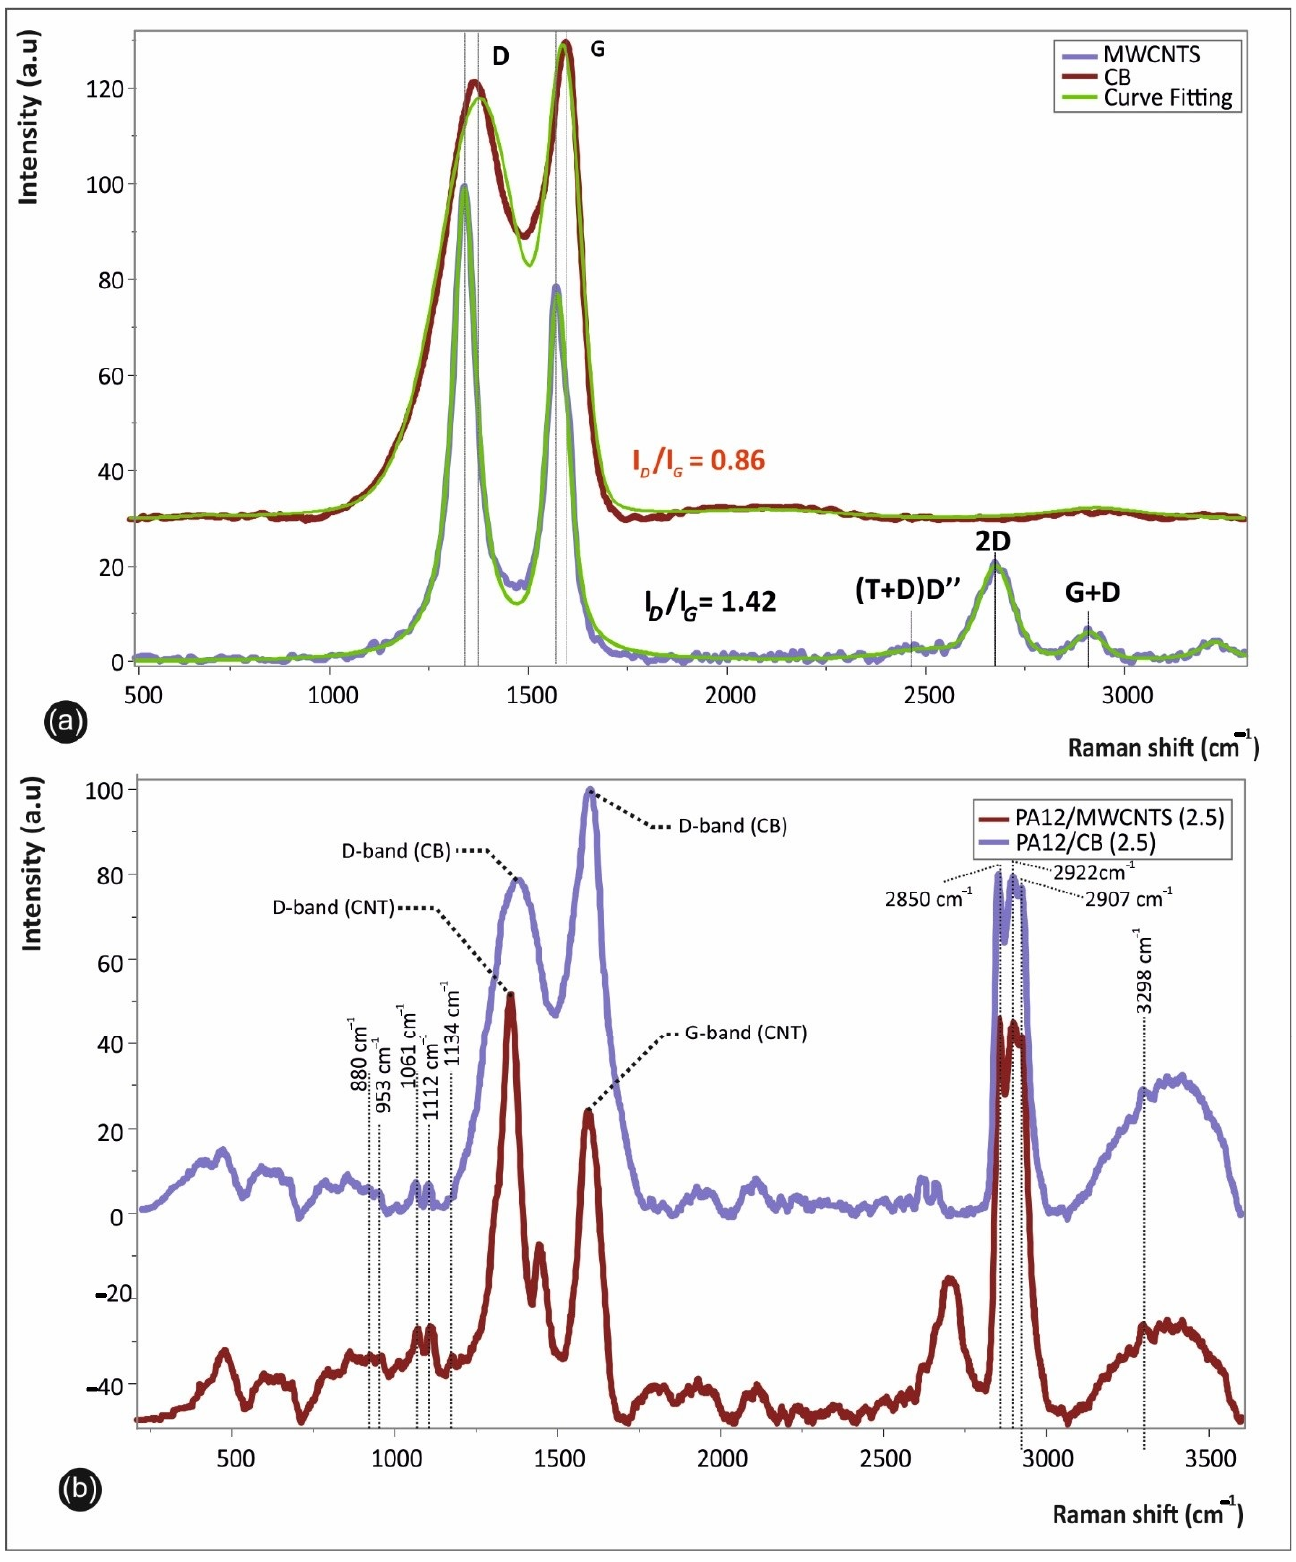
Figure 4. Raman spectra of ( a ) MWCNTs and highly graphitized CB carbon nanoallotrope fillers, together with the corresponding fitting lines; and ( b ) PA12/MWCNT and PA12/CB nanocomposites at 2.5 wt.% filler loading.